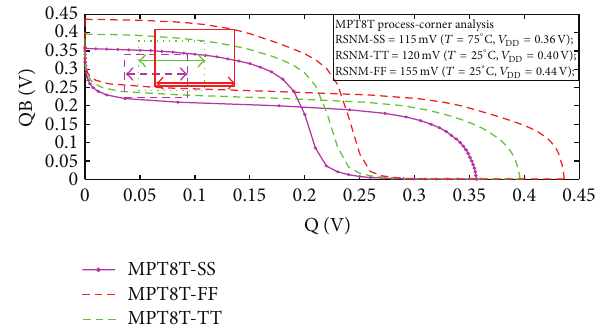
Figure 13: Process variations impact on RSNM of